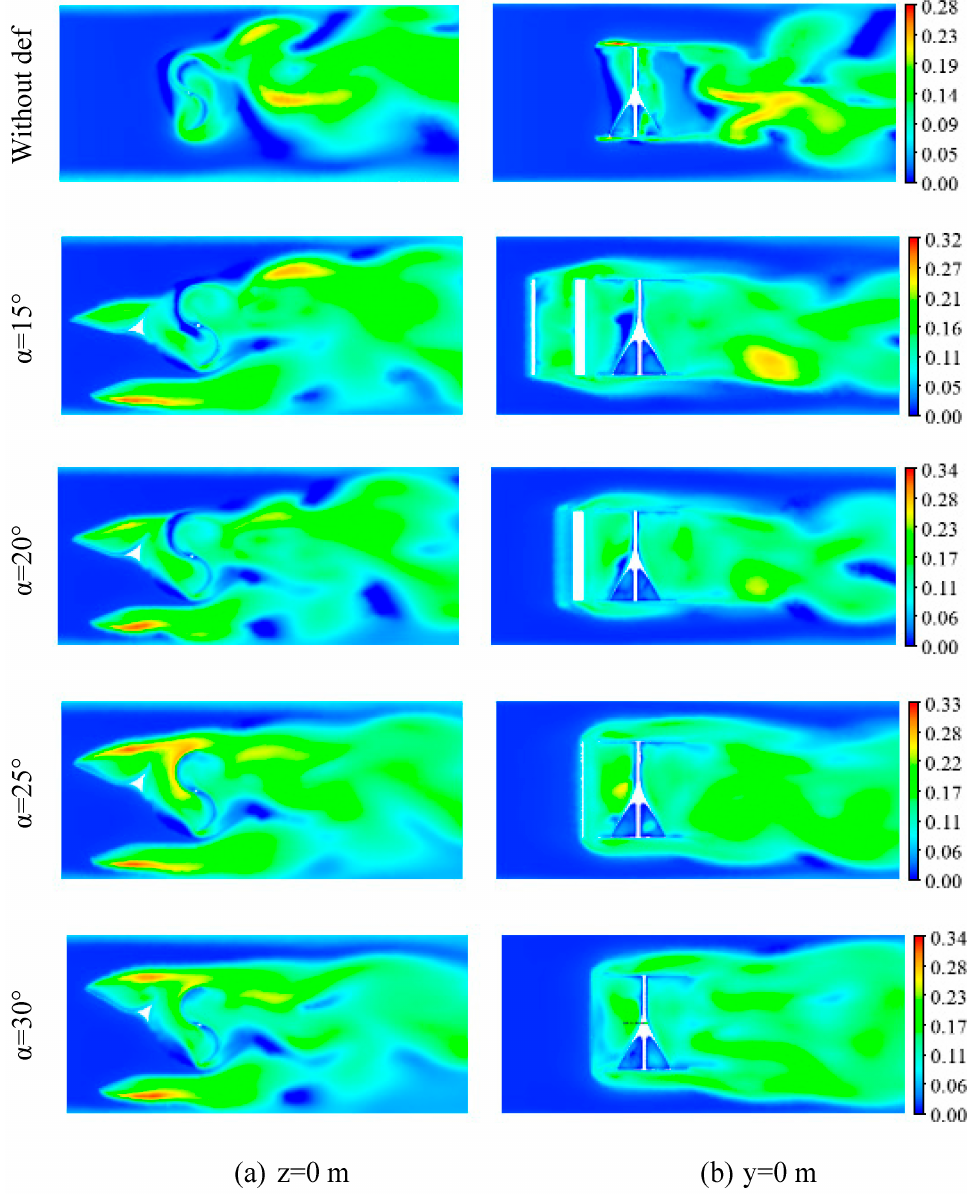
Figure 18. Turbulent intensity distribution for different deflection angles. Upstream the deflector system, the turbulent intensity seems to be weak for all con- figurations. Approaching the rotating domain of the helical Savonius rotor, it is noticed that the turbulent intensity increases brutally and shows important zones with a higher range of values located in front of the concave side of both the advancing and the re- turning blades (Figure 18a). By comparing the different configurations, it has been noted that these zones become more noteworthy with the increase in the deflection angle, mainly in front of the advancing blade. This is related to the creation of more vortices and so more viscosity detected there, as mentioned before. The use of a deflector system en- hances the rotation anti-clockwise by directing the flow to the concave side of the ad- vancing blade and redirecting an amount of it to the concave side of the returning blade. Downstream the rotor, a remarkably high turbulent intensity zone appears as an index of